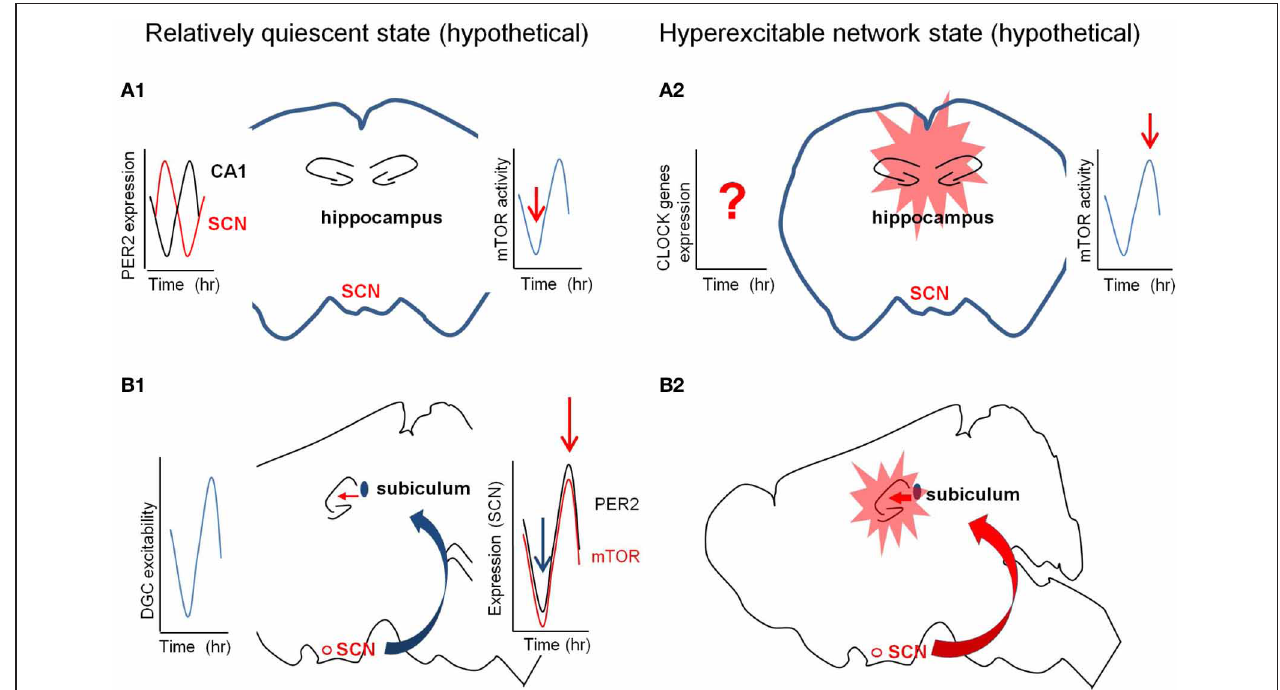
FIGURE 3 | Hypothetical diagrams of two different network excitability states. The left panel (in A1 and B1 ) is in quiescent state and the right (in A2 and B2 ) is in hyperexcitable state. (A) The circadian fluctuation of the expression and/or activity of mTOR signaling molecules in the hippocampus may determine the quiescent or hyperexcitable states of the hippocampus prone to epileptic seizures. The red arrows in the right graphs from the cartoon of the coronal section indicate the hypothetical activation states of